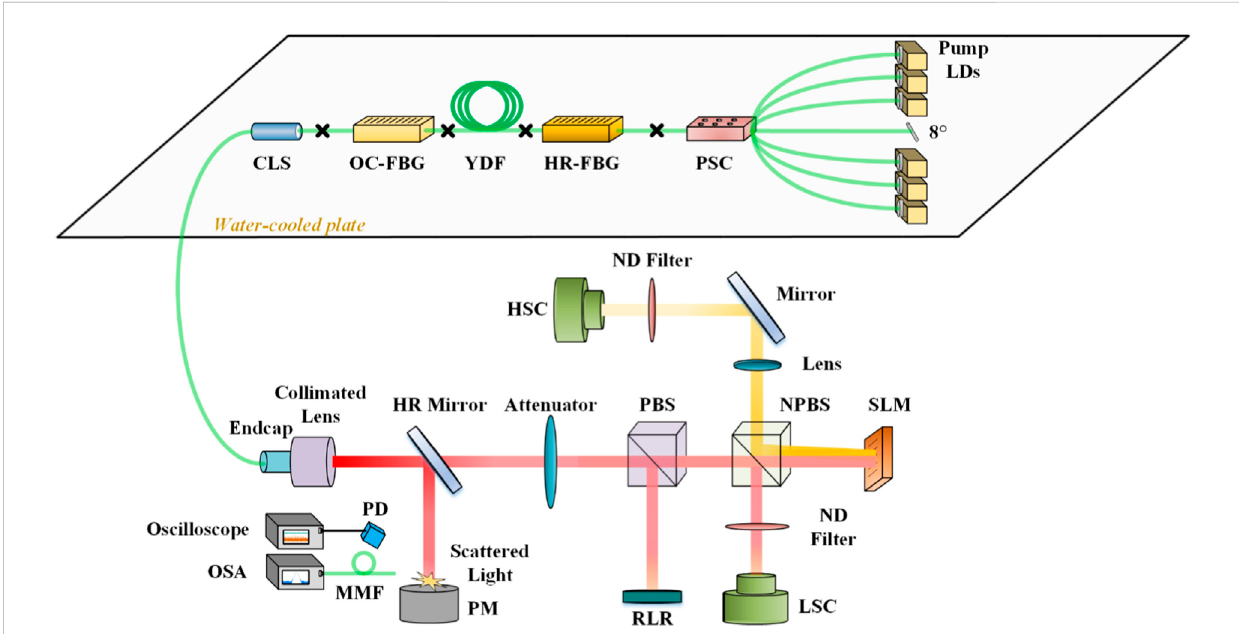
FIGURE 1 Aschematicdiagramofall- fi berlaseroscillatorandmeasurementsystem.(LDs,Laserdiodes;PSC,Pump-signalcombiner;HR,Highre fl ection;FBG, Fiber Bragg grating; OC, Output coupler; YDF, Ytterbium-doped fi ber; CLS, Cladding light stripper; PD, Photo-diode; OSA, Optical spectrum analyzer; MMF, Multi-mode fi ber; PM, Power meter; PBS, Polarizing beam splitter; NPBS, Non-Polarizing beam splitter; SLM, Spatial light modulator; ND, Neutral density; RLR, Residual light receiver; LSC, Low-speed camera; HSC, High-speed